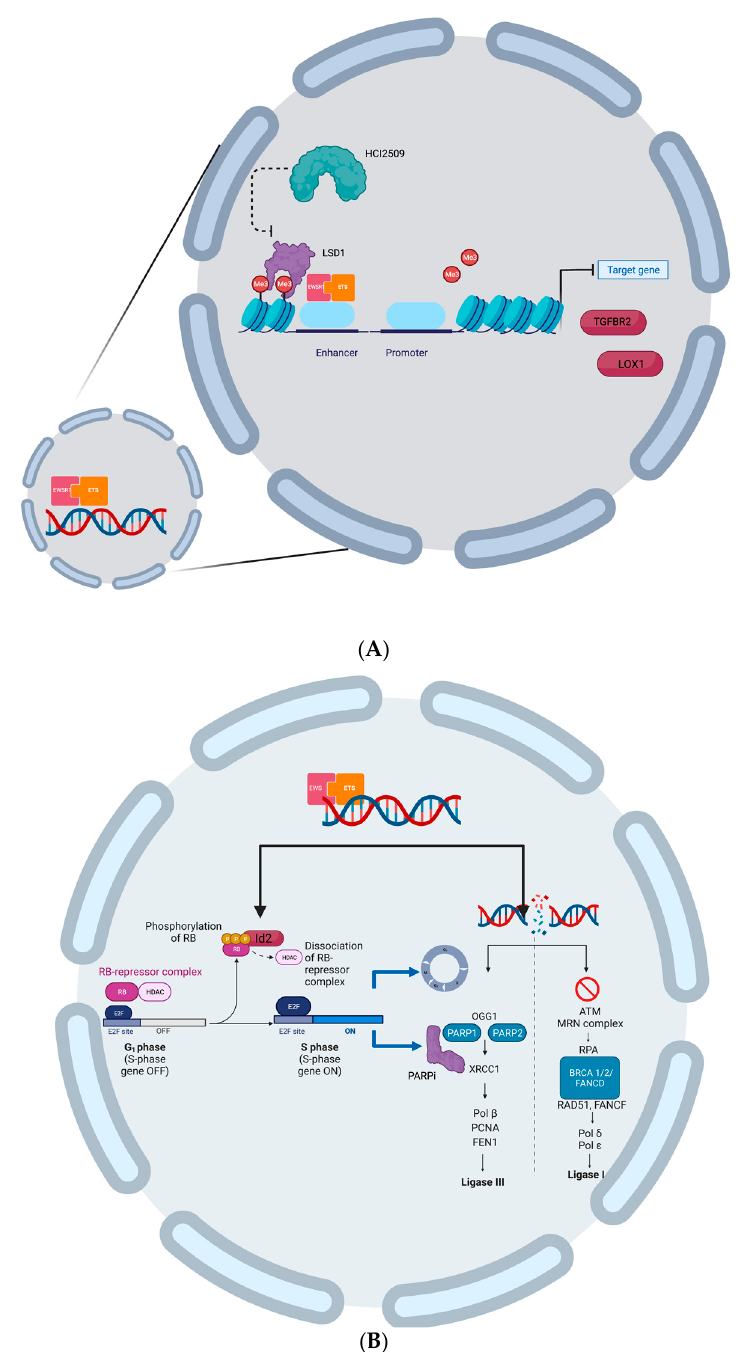
Figure 2. ( A ) EWSR1-ETS uses LDS1 to repress the expression of two target genes LOX and TGFBR2 that act as tumor suppressors; HCL2509 can inhibit LSD1 activity and reverse transcriptional activity of EWSR1-ETS. ( B ) EWSR1-ETS induces Id2 that releases E2f from RB inhibition; E2f induces cell cycle progression and PARP1 expression; replication and transcriptional stress lead to DNA damage that cannot be repaired either by PARP1, targeted by PARPi, nor by BRCA1 that is functionally absent in ES cells. (Created with BioRender.com).